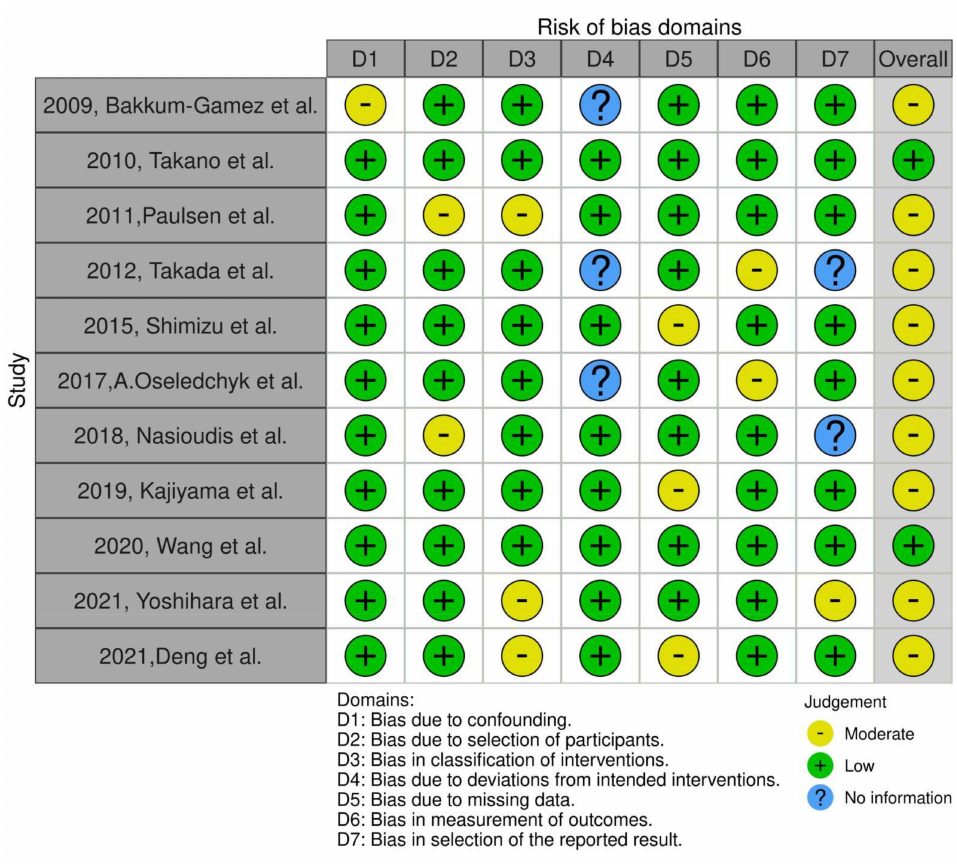
Figure 1. ROBINS-I evaluation of included studies